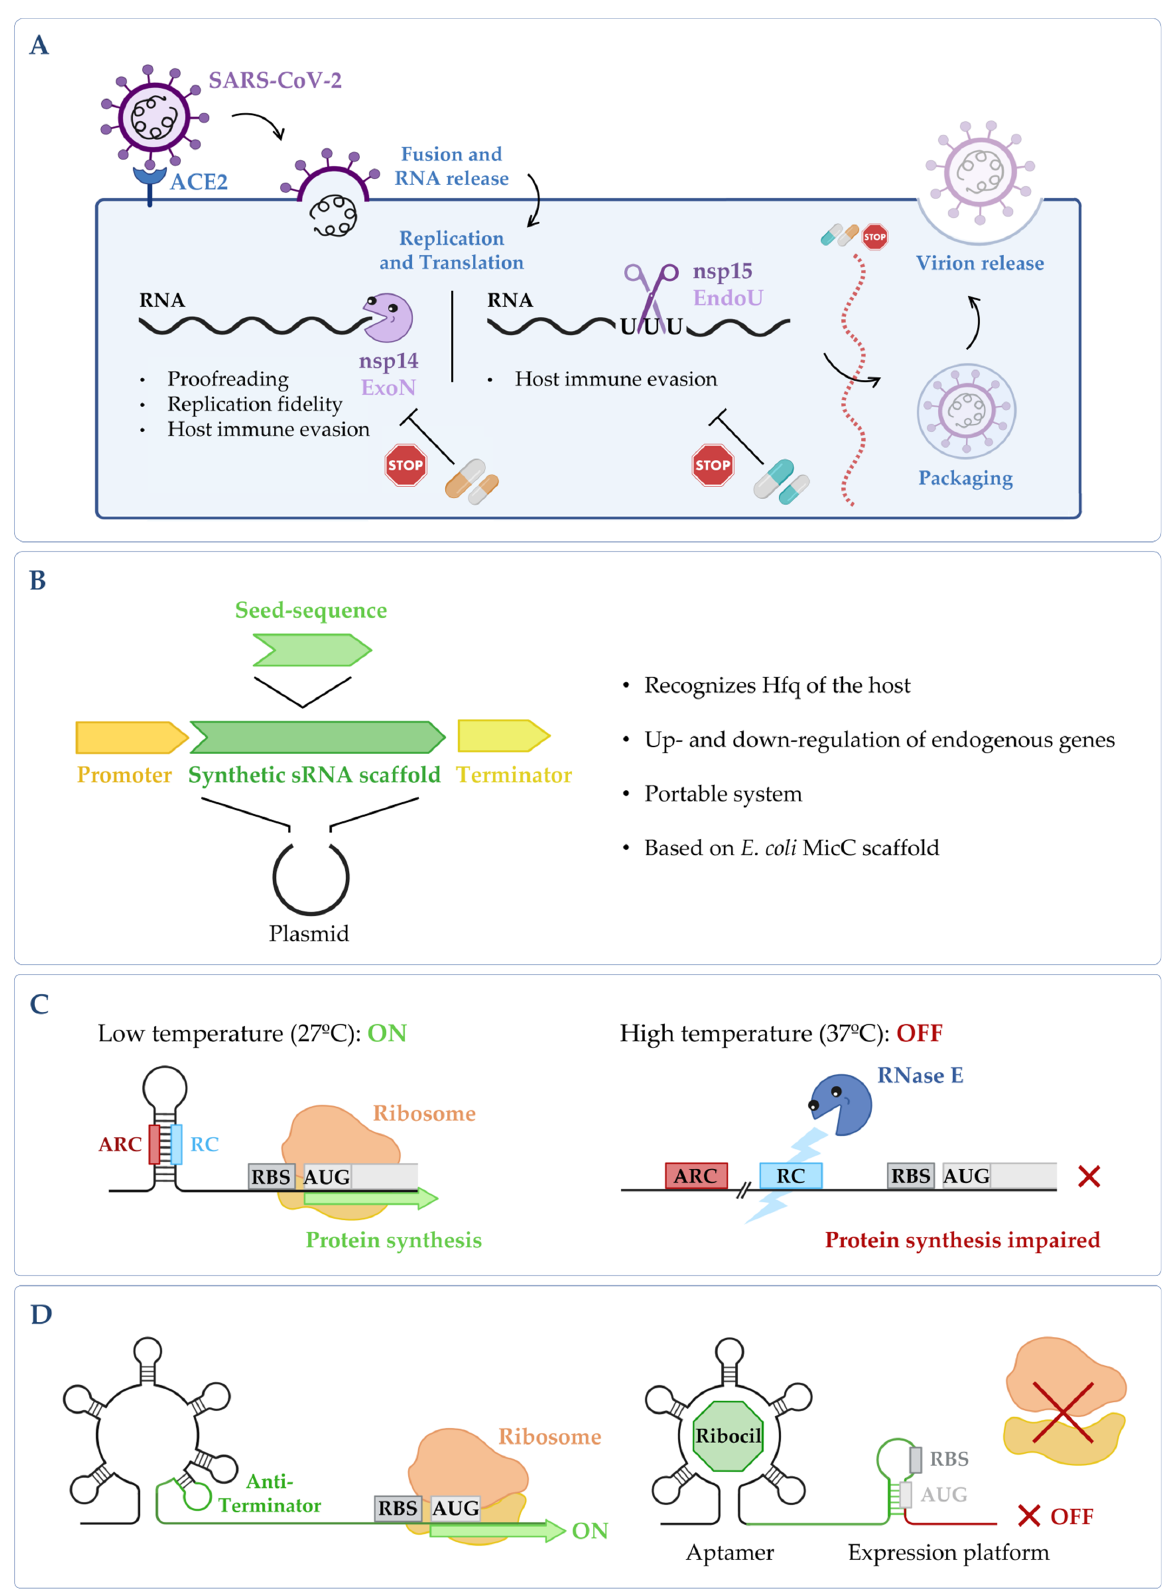
Figure 2. ( A ) Targeting fundamental viral proteins to inhibit SARS-CoV-2. The use of nsp14 and nsp15 ribonucleases as druggable targets may impair SARS-CoV-2 viral replication cycle, and therefore, it can be a good way to tackle infection. ( B ) Synthetic sRNA expression system. Vector containing